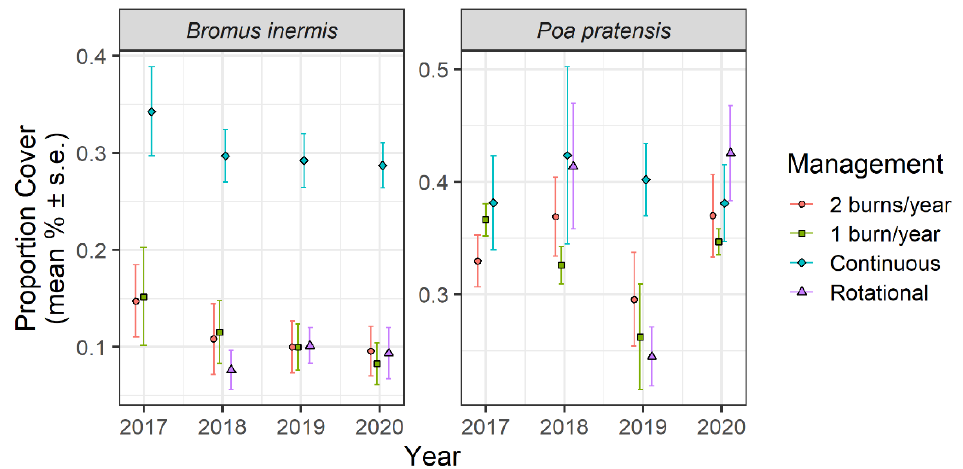
Figure 1. Cover of Bromus inermis and Poa pratensis over time in patch-burn treatments with one burn/year, two burns/year, continuous grazing, and modified rotational grazing systems from 2017 to 2020 at the Central Grasslands Research Extension Center in Streeter, ND. Error bars represent one standard error.